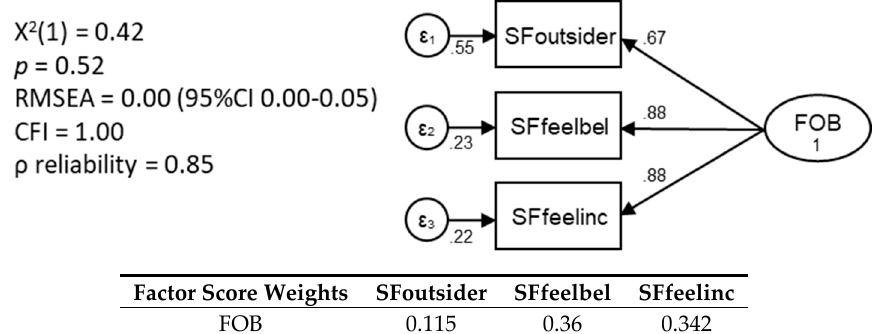
Figure A4. Final model for Feelings of Belonging construct of personal social cohesion.